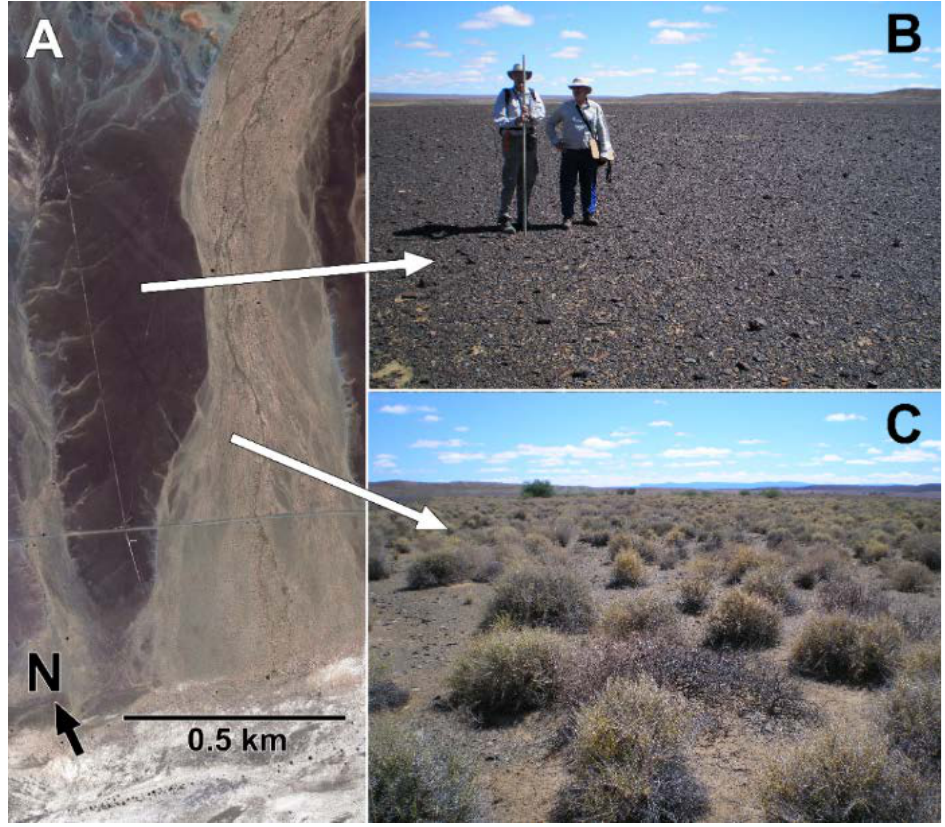
Figure 6. ( A ) Google Earth™ view of the Tankwa Karoo pediment site. The dark, elongated feature occupying most of the left half of the view is a pediment remnant covered with a dark stone pavement. The wide, light-coloured swath to the right of the pediment remnant is an ephemeral drainage (direction of flow to the south) and associated alluvial deposits inset below the pediment remnant. The white margin at the lower end of the image are deposits within the floodplain of the Tankwa River. Coordinates of the centre of the view: −32.318° S, 19.671° E ; ( B ) Co-authors McFadden (with pole) and Hoffman on the Tankwa Karoo pavement; ( C ) Vegetation on Holocene alluvial deposits east of the pavement surface is dominated by dense, hemispherical canopies of the coarse perennial grass, Cladoraphis spinosa (spiny love grass), with fibrous roots largely within the upper 20 cm of the soil. Less common woody plants with deeper taproots include the low shrub Tetraena (formerly Zygophyllum ) microcarpa (partly behind Cladoraphis canopy in centre foreground) and the small tree Acacia karroo (background).